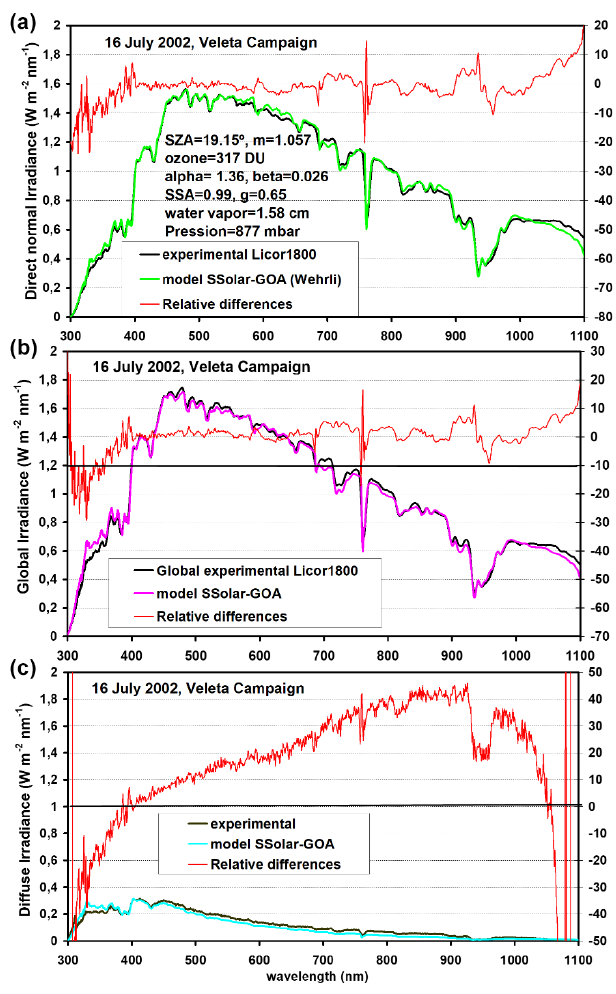
Figure 8. Comparison between the LI-1800 measurements and the SSolar-GOA model for direct, global, and diffuse spectral irradi- ances (from top to bottom) for 16 July 2002, at Pitres (Granada, Spain). The input parameters are specified at the top. Right y axis indicates the relative differences (%, in red colour) of measured mi- nus modelling data (only for the output data taken from the Wehrli